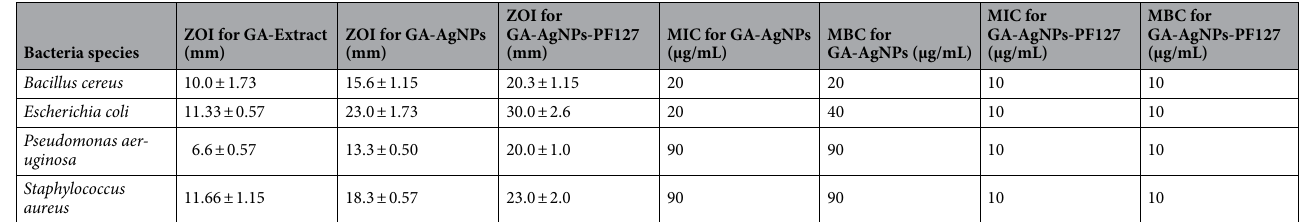
Table 2. Determination of diameter of zone of inhibition (ZOI), minimum inhibitory concentration (MIC) and minimum bactericidal concentration (MBC) of GA-extract, GA-AgNPs and GA-AgNPs-PF127 tested against four bacterial